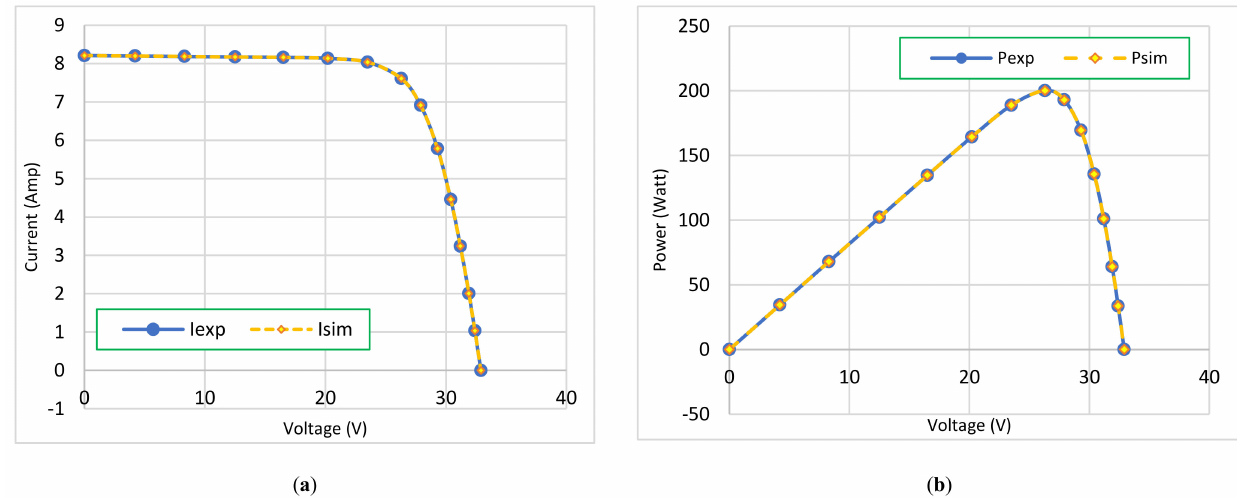
Figure 22. Characteristic curves for KC200GT TDM based on TFWO: ( a ) I–V ch/s and ( b ) P–V ch/s.